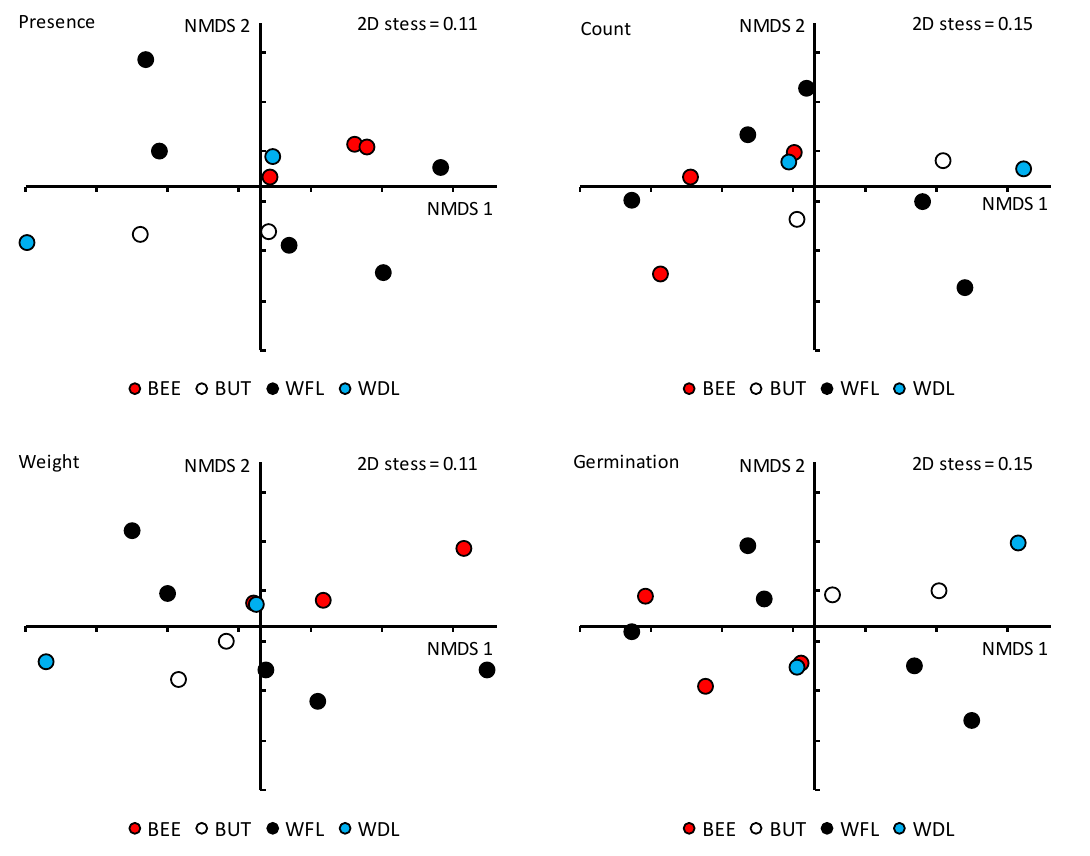
Figure 1. NMDS plots comparing composition of wildflower seed mixes based on presence or absence of each species, the seed count, the seed weight, and potential composition of final flowering mix based on germination rate of each species in each brand. BEE—bee-targeted brands; BUT—butterfly-targeted brands; WDL—wildlife targeted brands; WFL—wildflower mixes with no obvious target species/group on packaging.